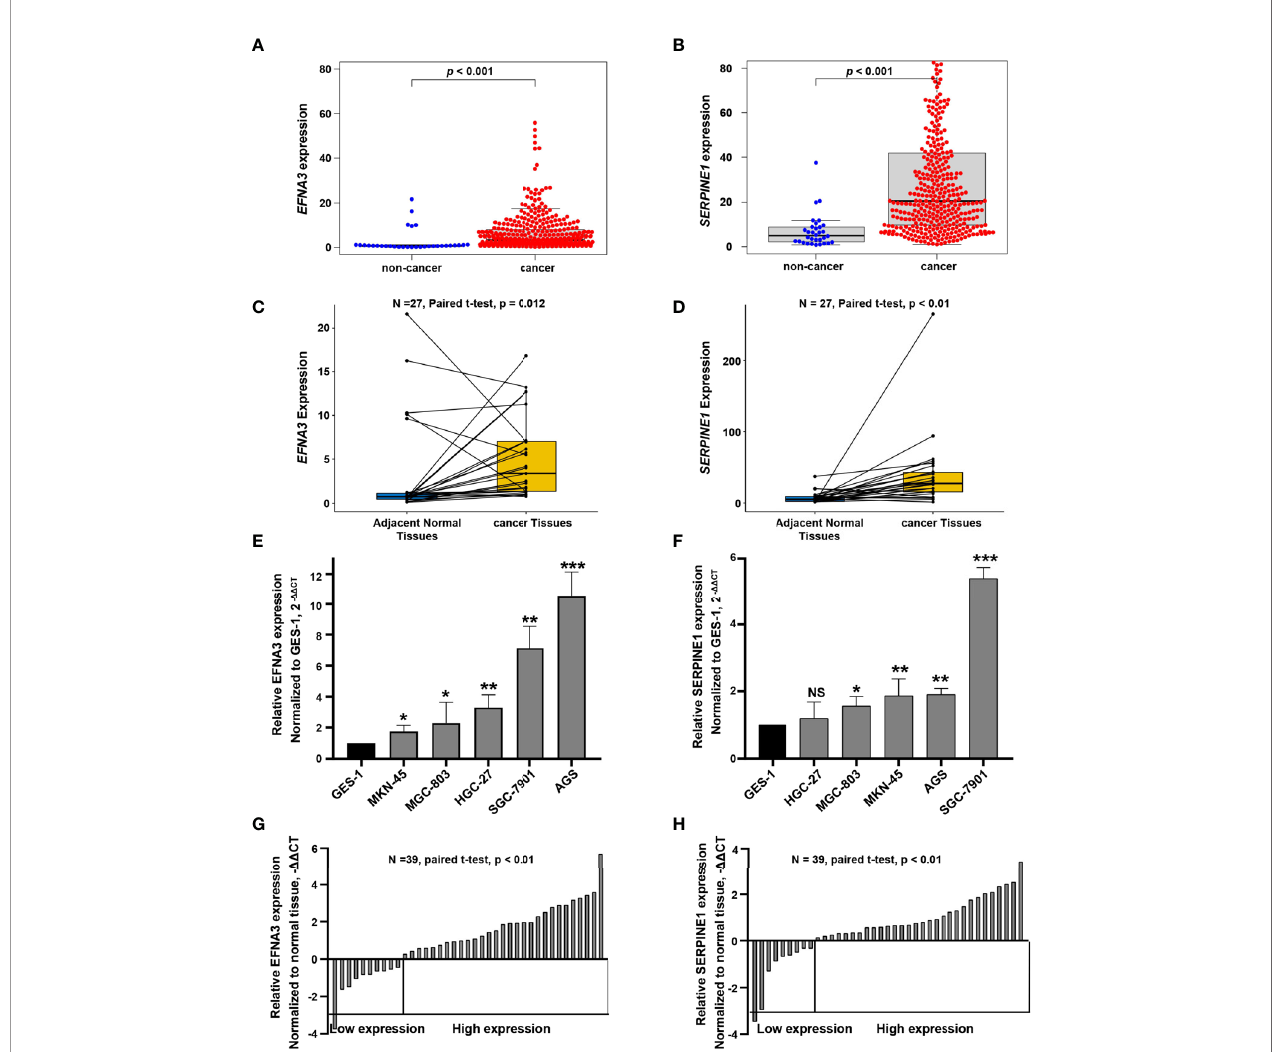
FIGURE 10 | EFNA3 and SERPINE1 are upregulated in gastric cancer cell lines and tissues. (A, B) Bioinformatics analysis of the expression of EFNA3 and SERPINE1 in cancer and non-cancerous tissues in TCGA. (C, D) Bioinformatics analysis of the expression of EFNA3 and SERPINE1 in 27 pairs of gastric cancer and adjacent non-cancerous tissues in TCGA. (E, F) qRT-PCR results of EFNA3 and SERPINE1 expression level in GES-1 and gastric cancer cell lines. (Data are presented as mean ± SD. NS: P ≥ 0.05, * P < 0.05, ** P < 0.01, *** P < 0.001). (G, H) qRT-PCR results of EFNA3 and SERPINE1 expression level in 39 pairs of gastric cancer and adjacent non-cancerous tissues. (Data are shown as – DD CT